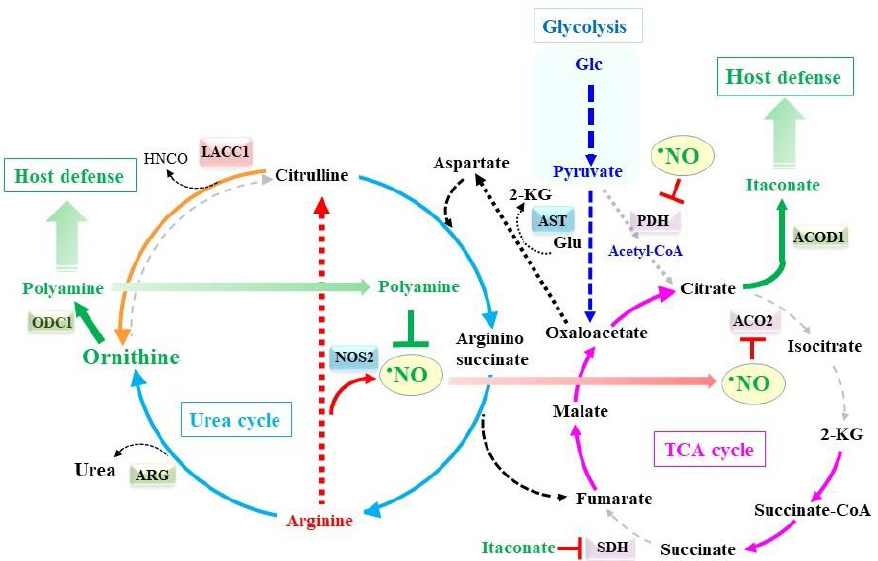
Figure 5. Crosstalk between the remodeled TCA cycle and urea cycle. The donation of nitrogen to citrulline from an amino group via argininosuccinate converts aspartate to fumarate. The resulting fumarate enters the TCA cycle and is converted into oxaloacetate through malate. Aspartate amino transferase (AST) then transfers an amino group from glutamate (Glu) to oxaloacetate and regenerate aspartate. Glutamate is regenerated by transferring an amino group from other amino acids. In total, the origin of urea nitrogen is amino acids, and none come from ammonia. LACC1 converts citrulline to ornithine and isocyanate by the action of isocyanic acid synthetase. Polyamines are synthesized from both citrulline and arginine via ornithine and suppress the production of •NO. As a result, overresponses of M1 macrophages, which are enabled by the remodeled TCA cycle, tend to be normalized by polyamines that are originated from the remodeled urea cycle.